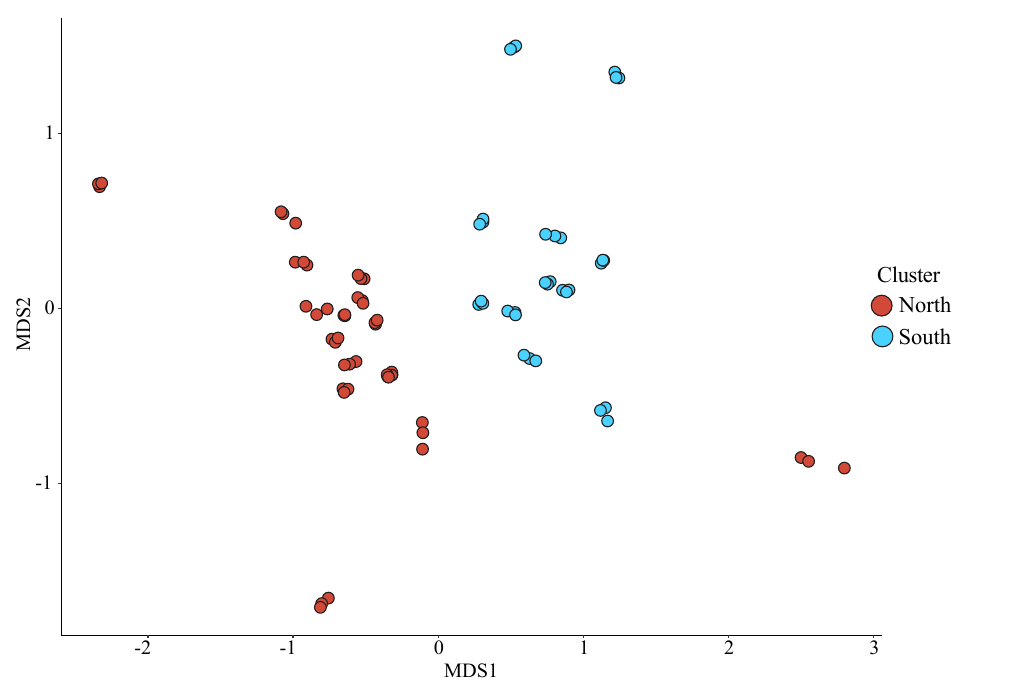
Figure 2. NMDS (stress = 0.1269098) showing the results of a SIMPROF (coloured categories) and the bacterial community composition similarities between locations. This cut-off occurred at latitude 30.29 ◦